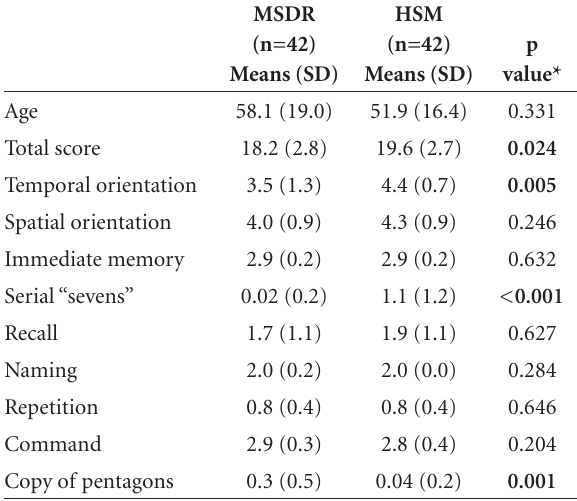
Table 2. Sample comparisons regarding age, and MMSE scores among